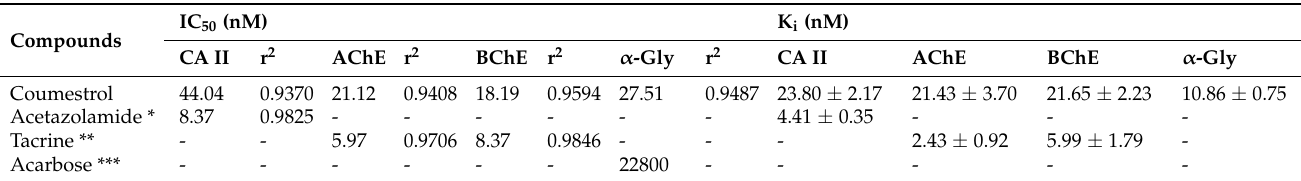
Table 3. The enzyme inhibition parameters of Coumestrol against carbonic anhydrase isoenzyme II (CA II), acetylcholinesterase (AChE), butyrylcholinesterase (BChE), and α -glycosidase ( α -Gly) enzymes.